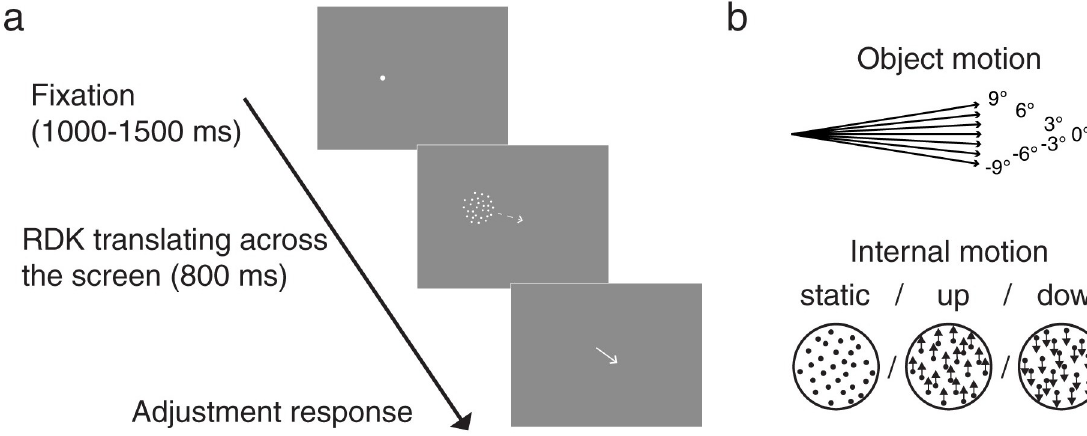
Fig 2. Trial timeline (a) and object and internal motion direction (b). At the beginning of each trial, a fixation point was shown for 1000– 1500 ms, followed by the RDK translating across the screen for 800 ms (dashed arrow is for illustration purposes and was not shown in the experiment). A response arrow was shown after the RDK until observers clicked the mouse button to submit their